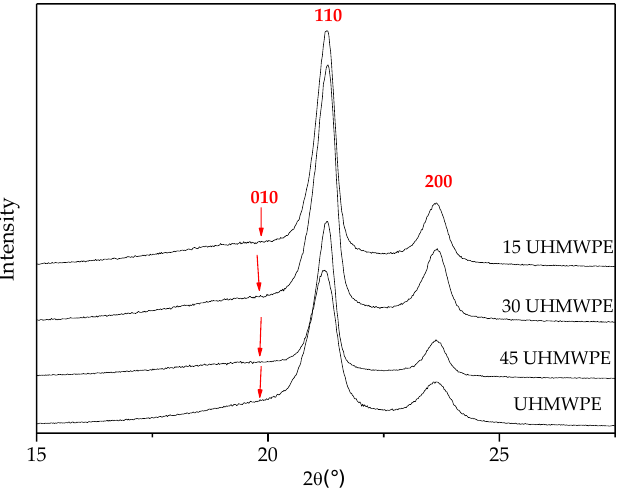
Figure 6. X-ray diffractograms of UHMWPE and the blends. The X-ray diffractogram of UHMWPE shows a weak reflection very close to the (110) peak (amorphous halo).